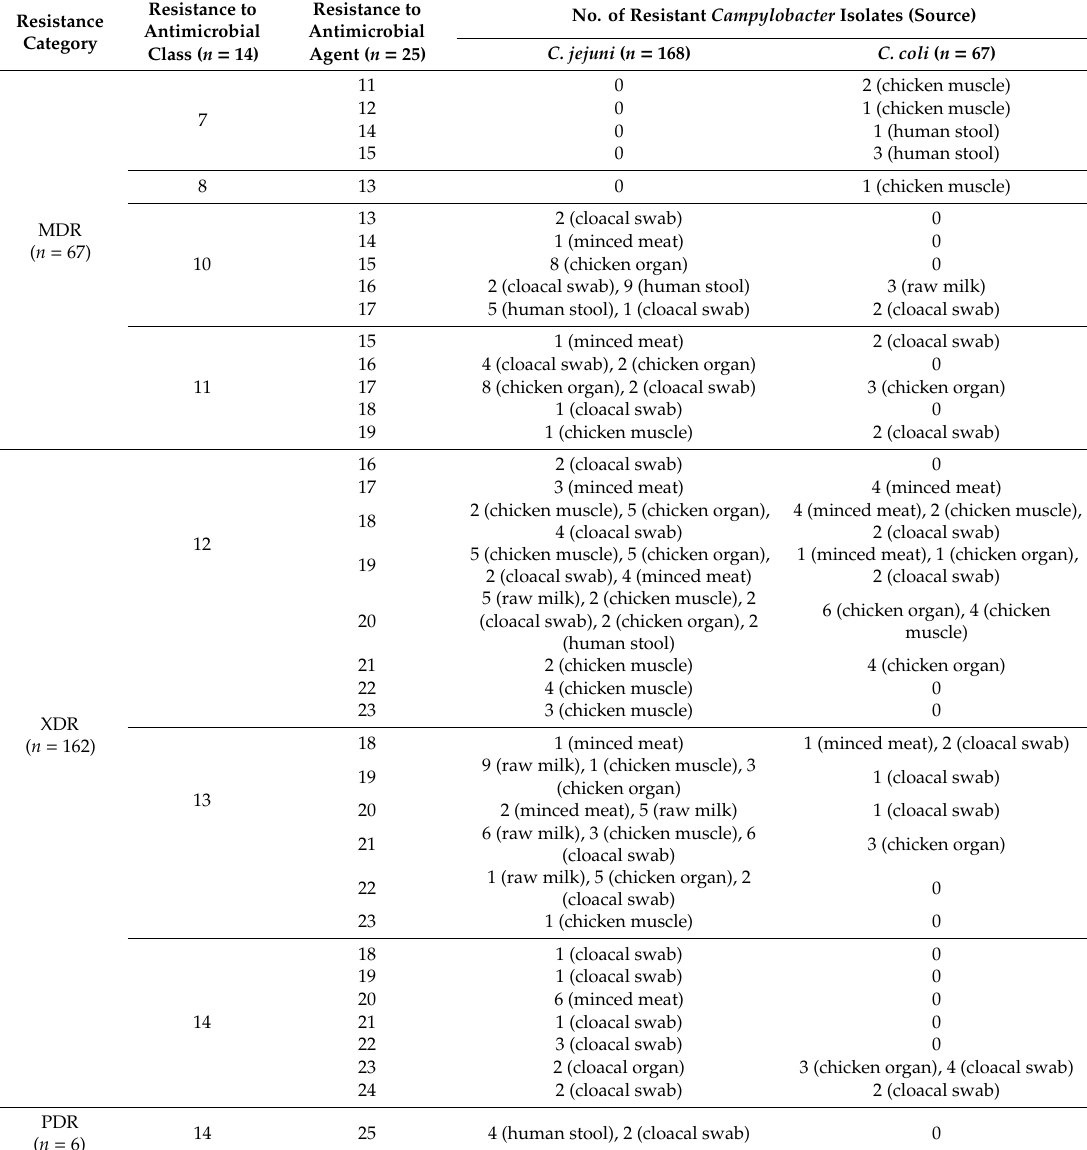
Table 3. Occurrence of MDR, XDR and PDR categories in Campylobacter isolates from di ff erent sources. Resistance